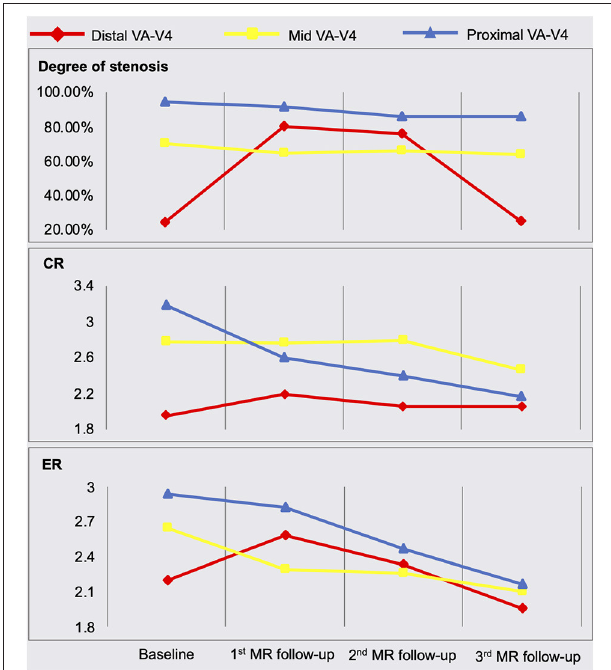
FIGURE 2 | Quantitative measurement results of plaque features. MRA, MR angiography; MR-VWI, MR vessel wall imaging; VA, vertebral artery; CR, plaque-wall contrast ratio; ER, plaque enhancement